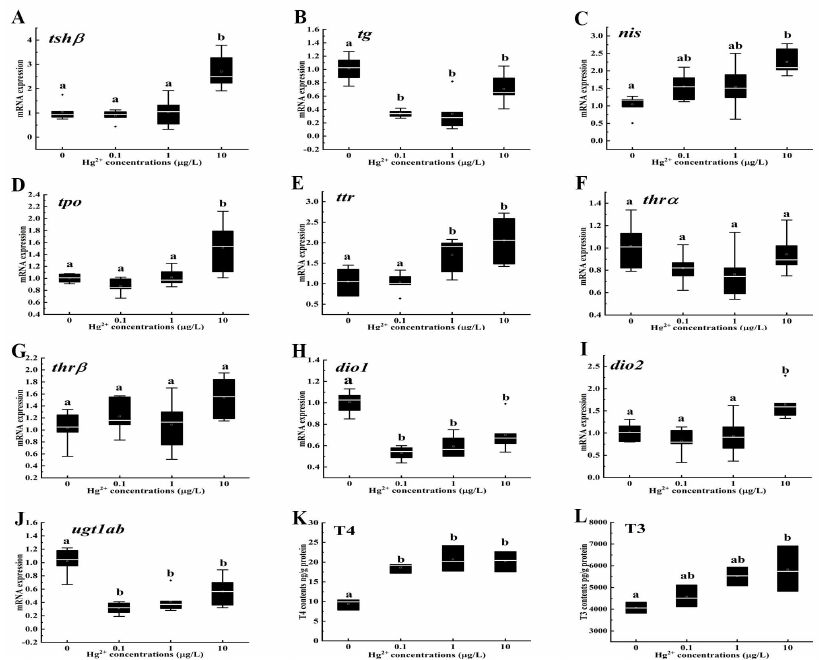
Figure 2. Transcription levels of tsh β ( A ), tg ( B ), nis ( C ), tpo ( D ), ttr ( E ), thr α ( F ), thr β ( G ), dio1 ( H ), dio2 ( I ), ugt1ab ( J ) and contents of T4 ( K ), T3 ( L ) in zebrafish embryos (2 hpf) that were treated with Hg 2+ (0, 0.1, 1, and 10 μg/L) for 120 h. Data are shown as mean ± SD (n = 6). Different letters denote significant differences between groups ( p < 0.05).